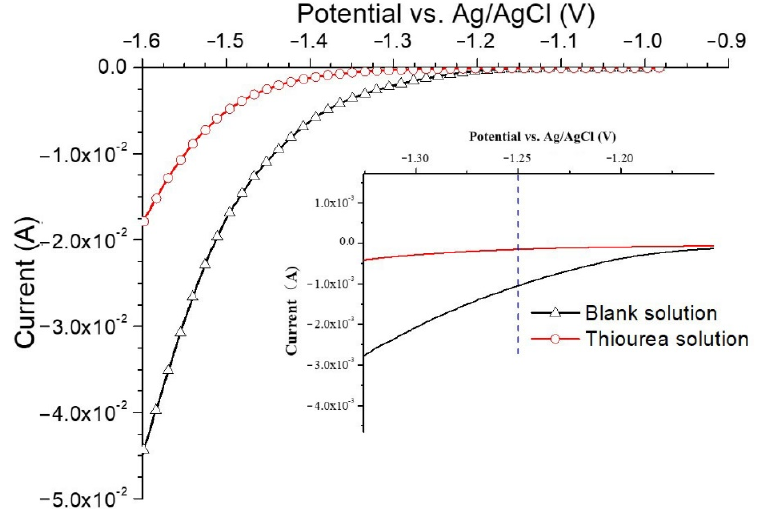
Figure 5. Linear sweep voltammogram between − 0.9 V (vs. Ag/AgCl) and − 1.6 V (vs. Ag/AgCl) for NaOH solution with and without thiourea and a larger version of the linear scanning volt-ampoule method (LSV) at − 1.25 V (vs. Ag/AgCl) (scan rate 2 mV/s).